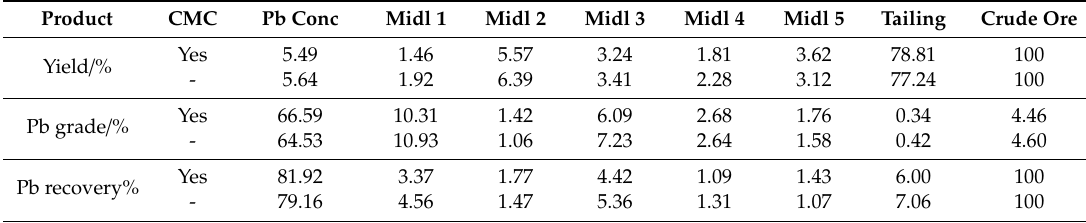
Table 7. Results of open circuit test/%.